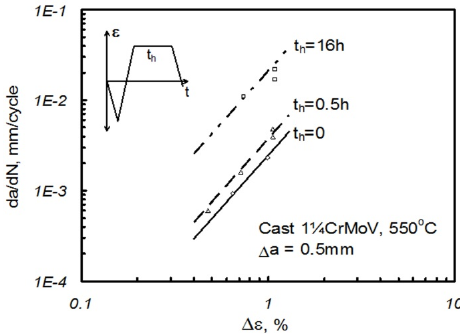
Figure 9. Comparison of short crack growth rates after 0.5 mm crack extension from notch root in large SENB feature specimen creep ‐ fatigue tests on cast 1¼CrMoV steel at 550 °C.